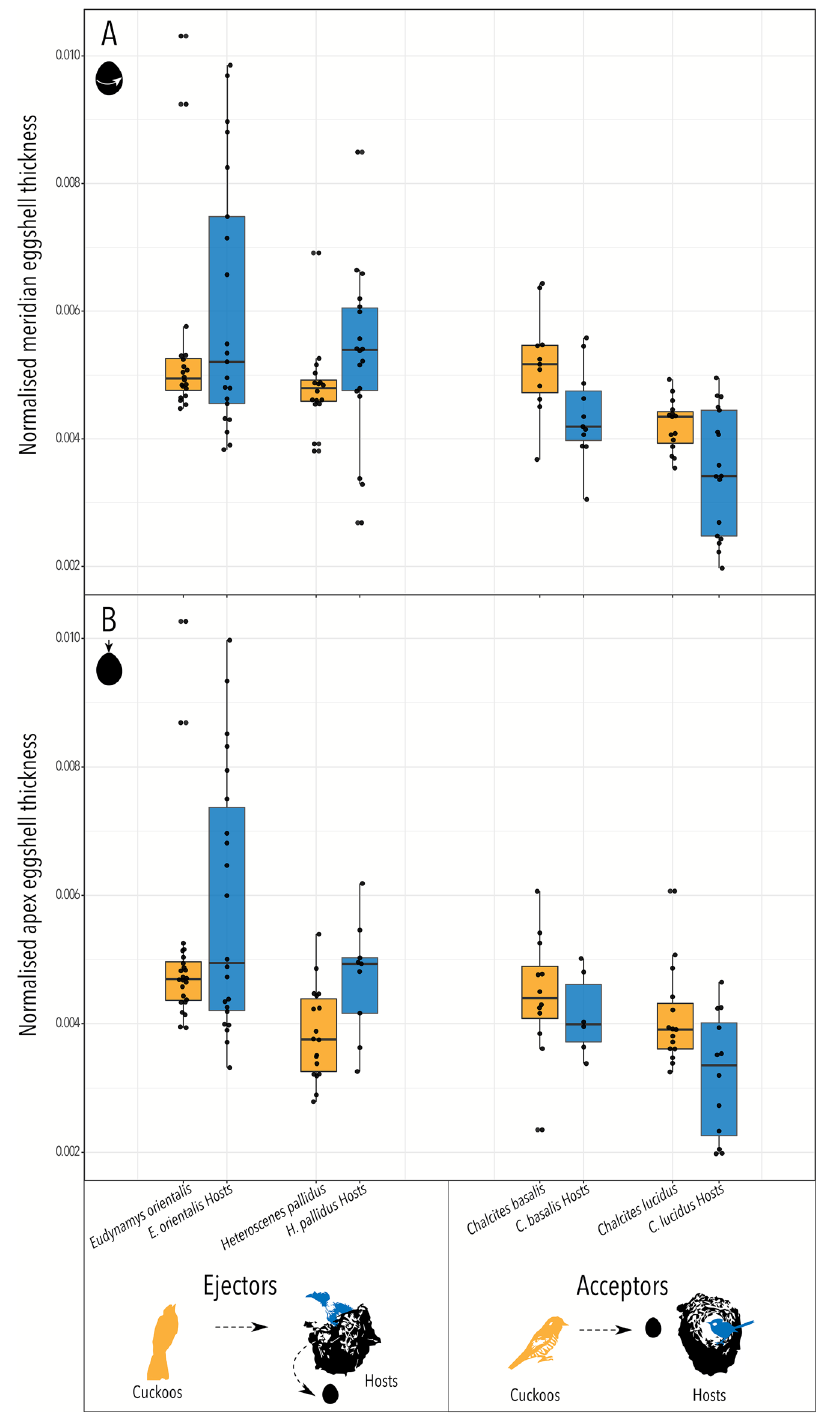
Figure 2. Eggshell thickness of cuckoos (orange) and their hosts (blue). Eggshell thickness was measured at two points on the egg: ( A ) the meridian of the egg, which is the circumference around the widest part of the egg and ( B ) the apex of the egg, which is the most conical end opposite the air sac. Eggshell thickness was normalised for interspecies comparisons by dividing the mean eggshell thickness of each egg by its length. The total eggshell thickness distribution is shown as black dots (Supplementary data file 1). Box plots are the median, interquartile range (Q1–Q3) and range (min–max). Raw data prior to normalisation are displayed in Fig.